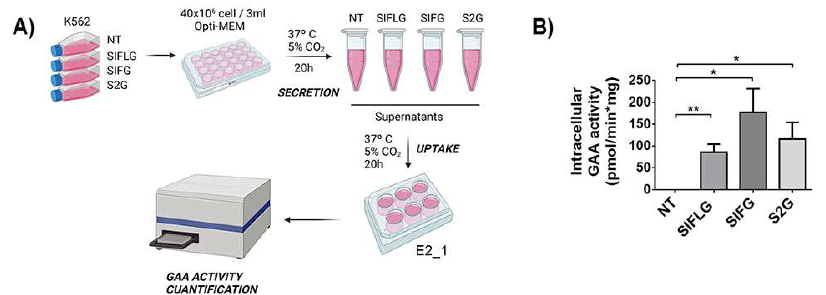
Figure 6. IFG-derived peptide allows a better GAA activity recovery in GAA-KO Sol8 cells. ( A ) Scheme protocol of mGAA secretion into the medium (supernatants/conditioned media) by transduced K562 cells and its uptake by E2_1 cells. Image created with BioRender.com. ( B ) mGAA intracellular activity after the addition of conditioned media to E2_1 cells. NT as a negative control (supernatant from non-transduced K562 cells). Statistical analyses: unpaired t -test (two tails, * p < 0.05, ** p < 0.01). Values represent means +/ − SEM of at least three separate